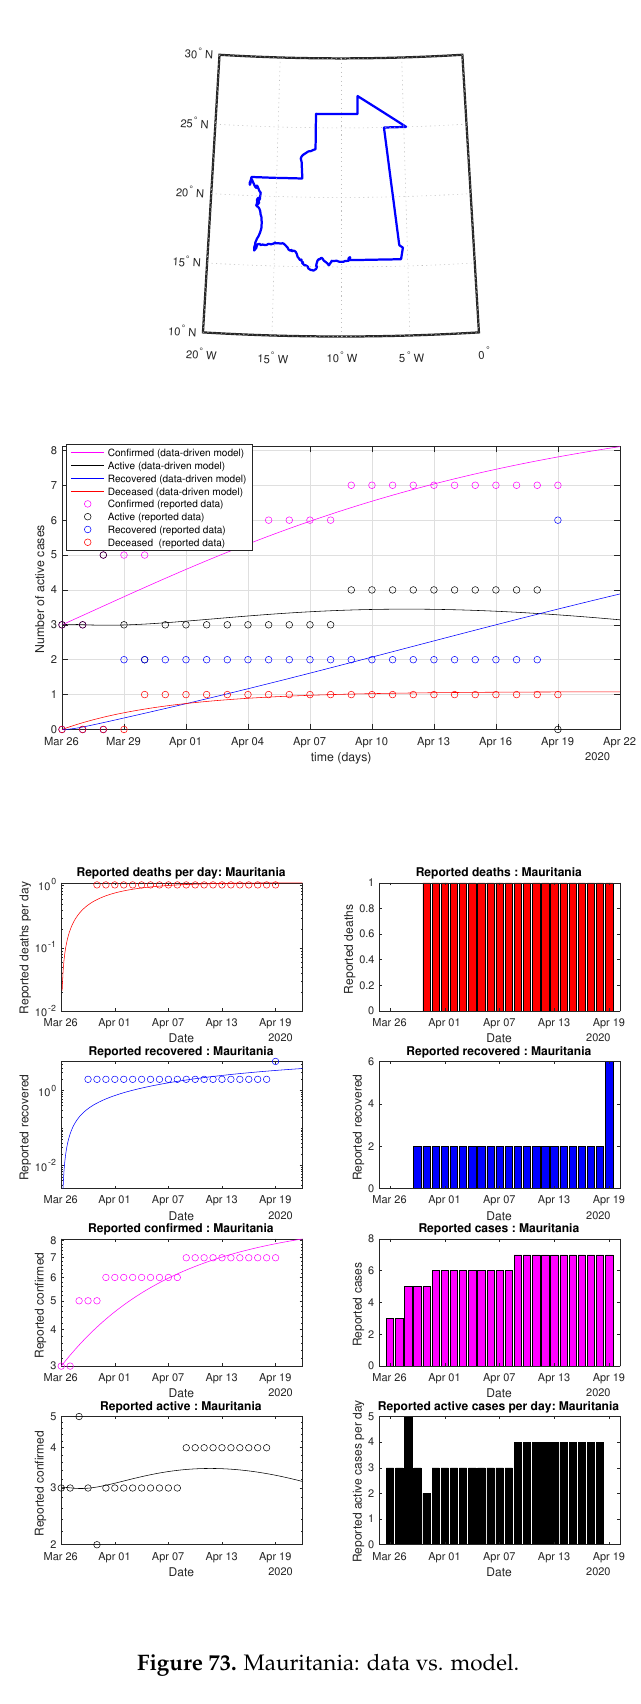
Figure 73. Mauritania: data vs.